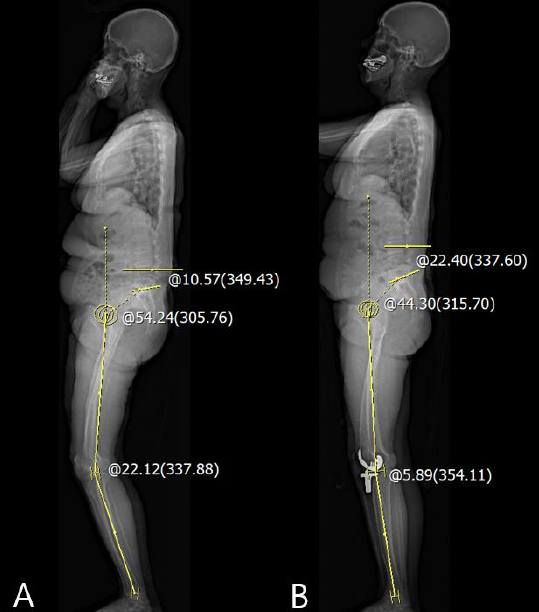
Figure 4. Corrected closed to neutral knee alignment decreased PT and increased SS. ( A ) Measure- ment of the preoperative sagittal HKA angle: sagittal HKA Rt-Lt = +22.12° and preoperative PT: +54.24° and SS: +10.57°; ( B ) measurement of the postoperative sagittal HKA Rt-Lt = +5.89° and PT: +44.30° and SS: +22.40°.